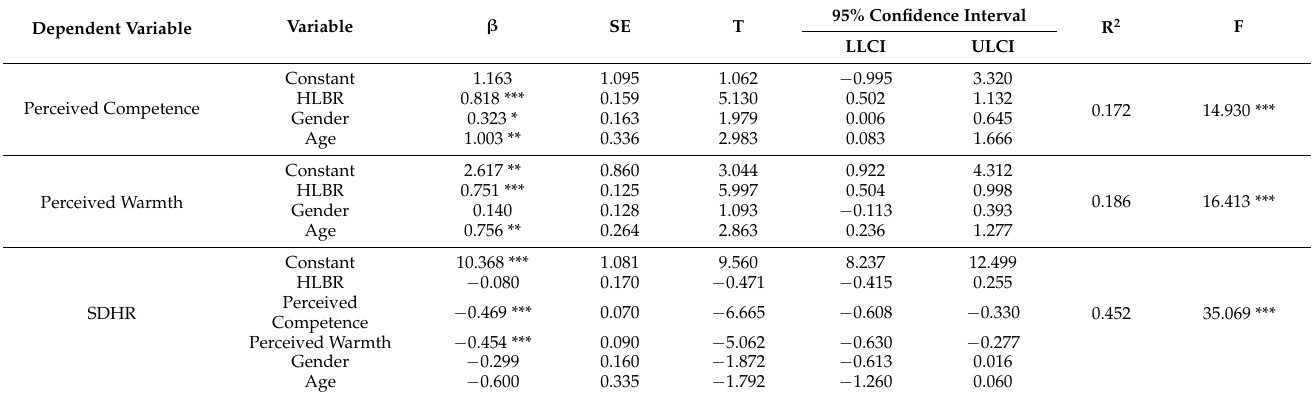
Table 5. Model test of mediation analysis (China).